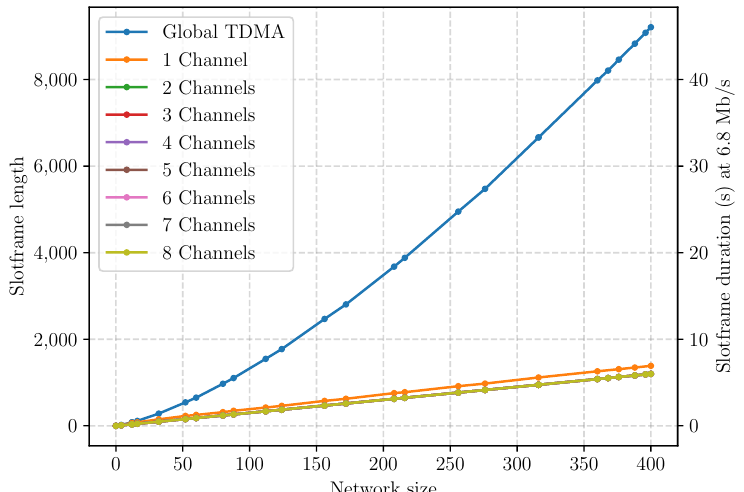
Figure 21. Slotframe length as a function of the network size and the number of allowed